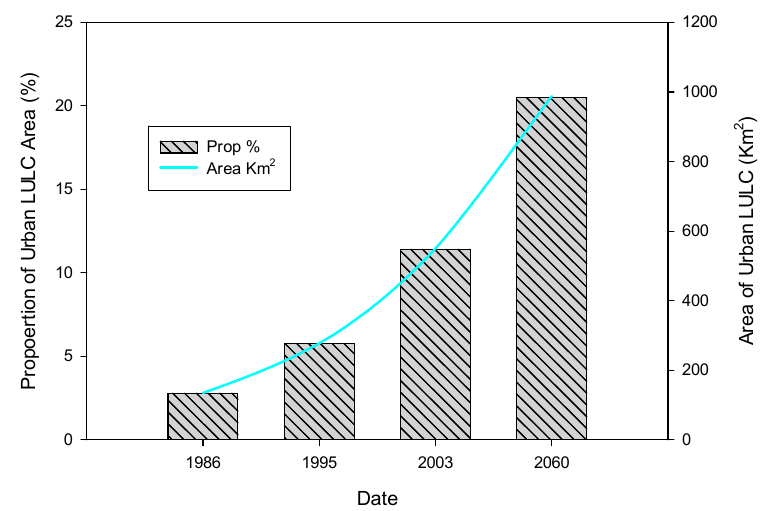
Figure 8. Proportion and trend of urban area changes between 1986–2060. The bar chart shows the proportion of urban area for the respective dates. The line graph shows the trend and changes in urban land-use area.